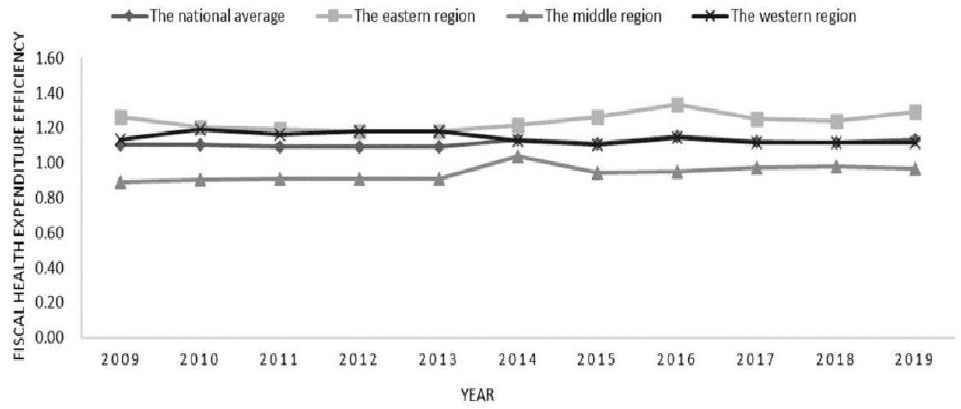
Figure 1. Changes in the fiscal health expenditure efficiency by region in China from 2009 to